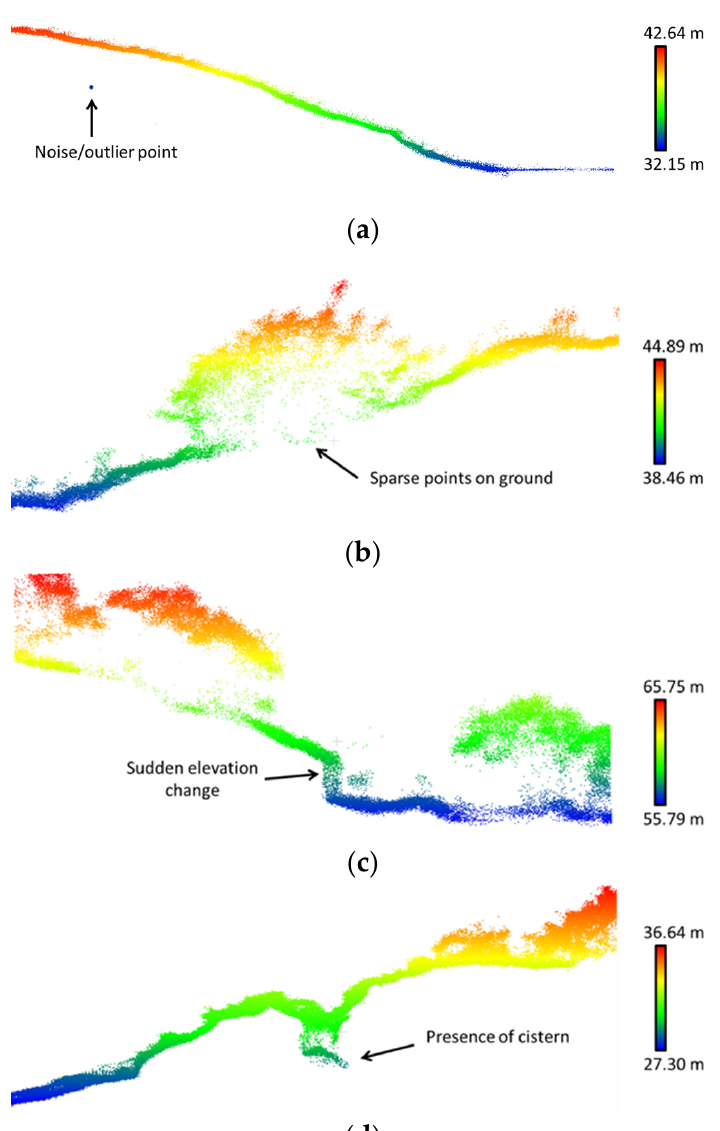
Figure 10. Sample LiDAR point clouds (colored by height) showing the challenges in DTM generation: ( a ) presence of noise/outlier points; ( b ) sparse points on the ground caused by dense vegetation; ( c ) rugged terrain with sudden elevation change; and ( d ) presence of an underground structure.